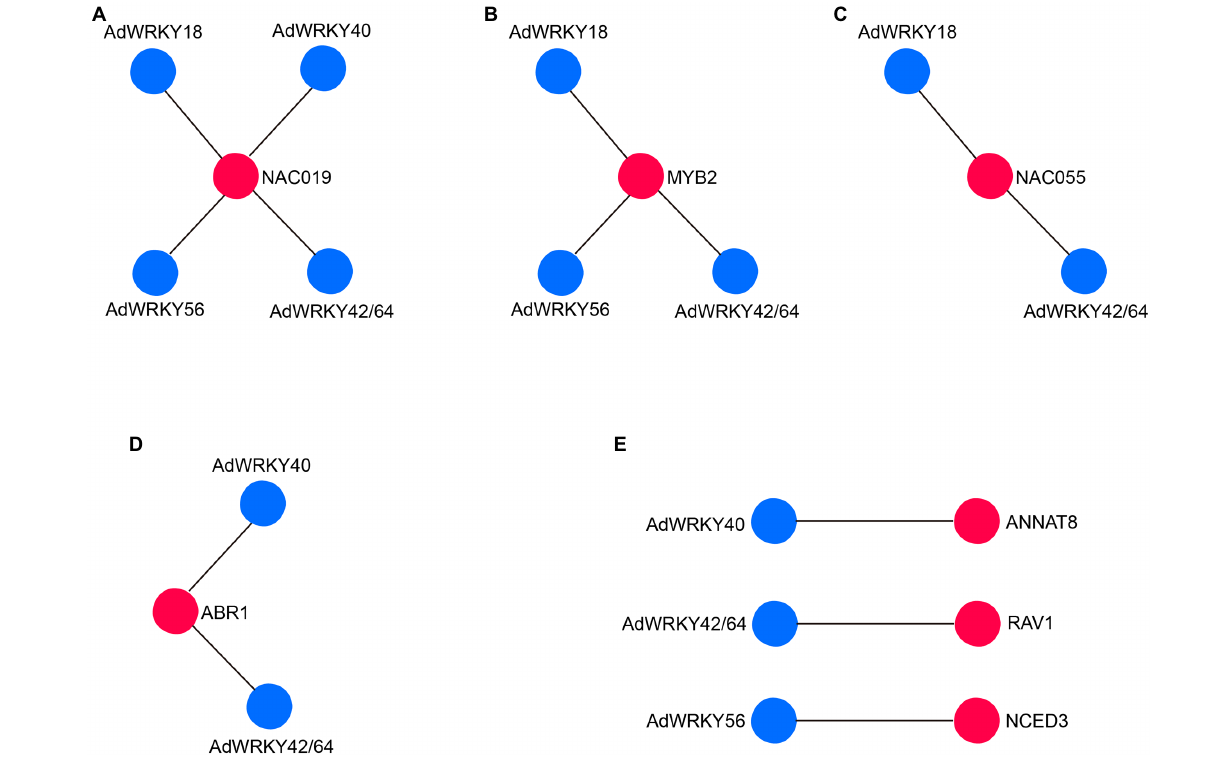
FIGURE 4 | AdWRKYs interaction with proteins with drought-tolerance function based on Arabidopsis . (A) NAC019 interaction with AdWRKYs. (B) MYB2 interaction with AdWRKYs. (C) NAC055 interaction with AdWRKYs. (D) ABR1 interaction with AdWRKYs. (E) Interaction between AdWRKYs and other specific